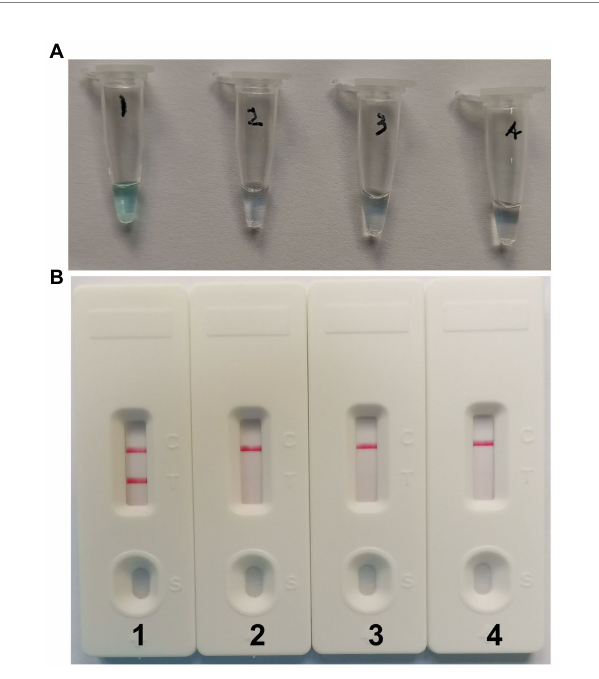
FIGURE 2 Identification and confirmation of CVA16-MCDA-LFB products. (A) The visible color changes of amplification products of CVA16- MCDA-LFB assay were analyzed by VDR. (B) The products of